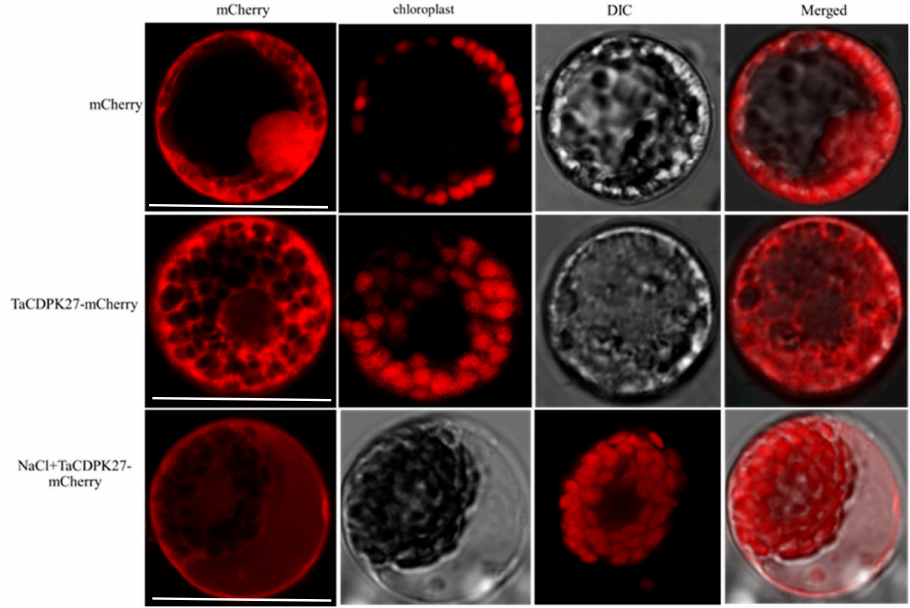
Figure 5. Subcellular localization of TaCDPK27. Wheat protoplasts were transformed with pAN583:mCherry or TaCDPK27-mCherry via the polyethylene glycol (PEG)-mediated method. TaCDPK27 is mainly localized to the cytoplasm in wheat protoplasts. Under salt stress conditions, some of TaCDPK27 was transferred to the membrane. Bar = 50 µ